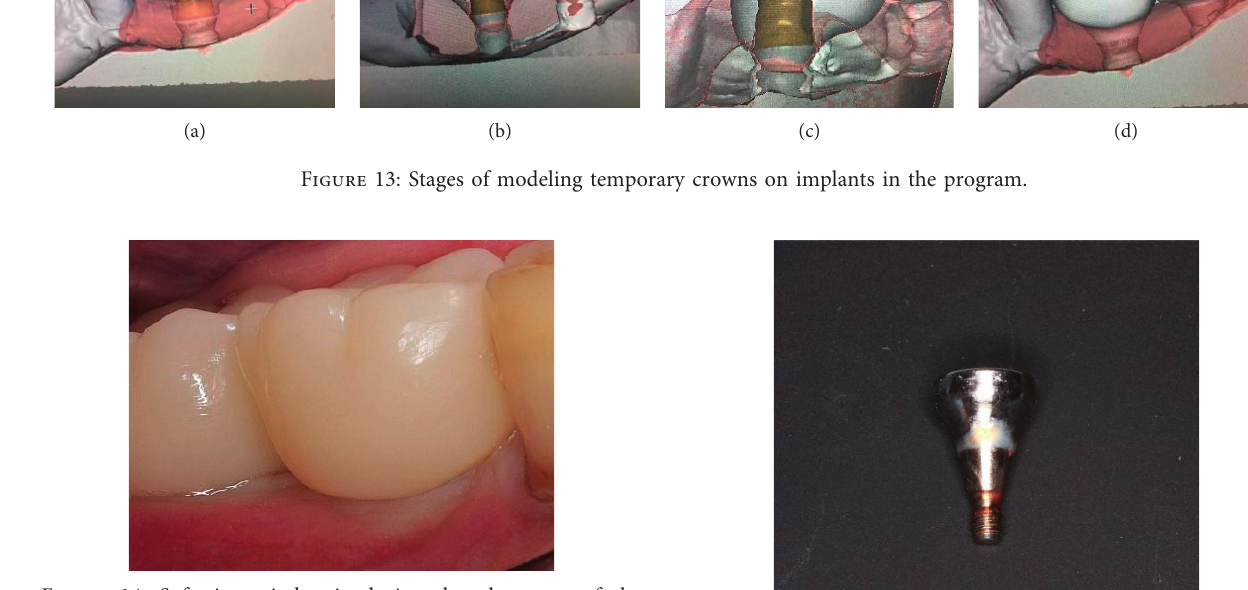
Figure 14: Soft tissue ischemia during the placement of the provisional prosthesis.